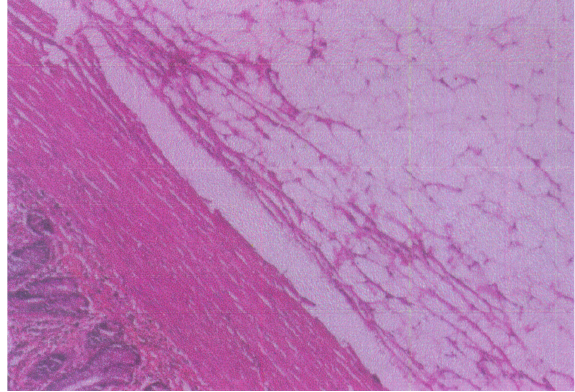
Figure 4: Histopathology showing